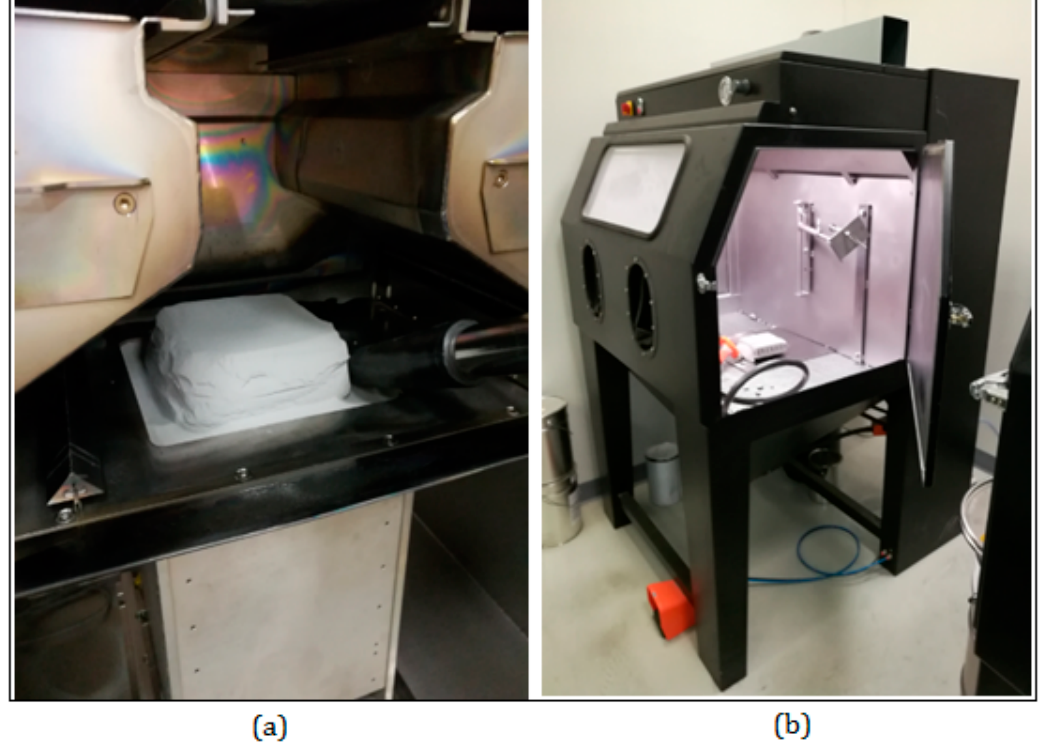
Figure 7. ( a ) The build with sintered powder; ( b ) Powder recovery system.